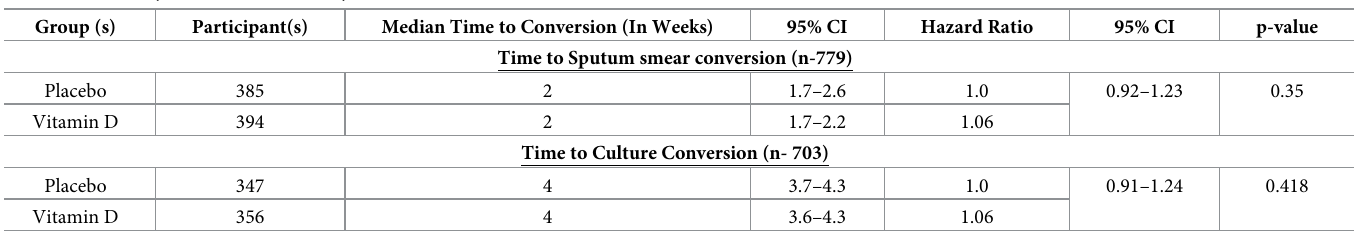
Table 3. Secondary outcomes of the study.